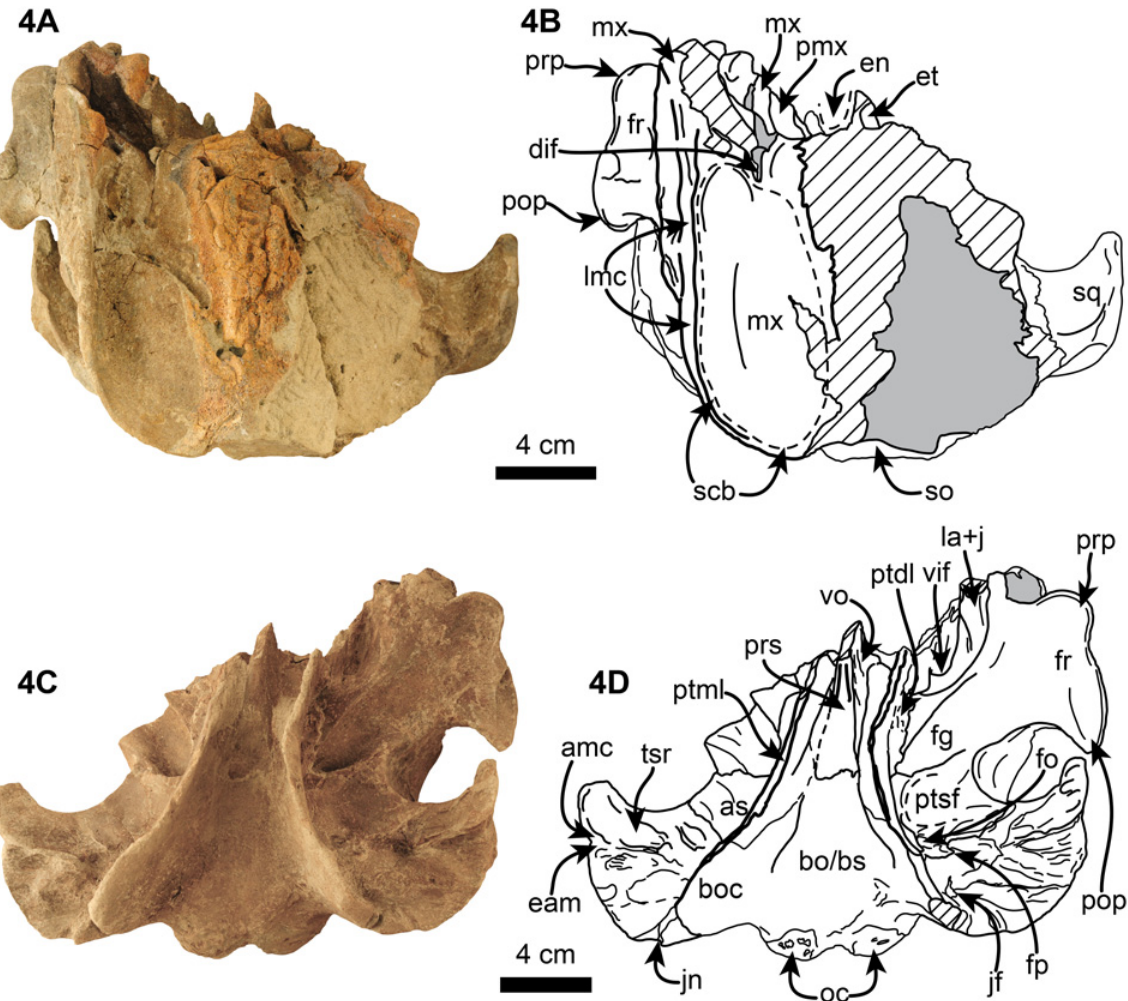
Fig 4. Dorsal, 4A-B, and ventral, 4C-D, views of referred specimen of Nanokogia isthmia gen. et sp. nov. (UF 273554). Abbreviations: amc, anterior meatal crest; as, alisphenoid; bo, basioccipital; boc, basioccipital crest; dif, dorsal infraorbital foramen; eam, external auditory meatus; en, external nares; fg, frontal groove; fo, foramen ovale; fp, falciform process of squamosal; fr, frontal; jf, jugular foramen; jn, jugular notch; la+j, lacrimal + jugal; lmc, lateral maxillary crest; mx, maxilla; oc, occipital condyles; pmx, premaxilla; pop, postorbital process; prp, preorbital process; prs, presphenoid; ptdl, dorsal lamina of pterygoid; ptml, medial lamina of pterygoid; ptsf, pterygoid sinus fossa; scb, supracranial basin; so, supraoccipital; sq, squamosal; tsr, tympanosquamosal recess; vif, ventral infraorbital foramen; vo, vomer. Gray shaded areas indicate sediment; diagonal lines denote broken